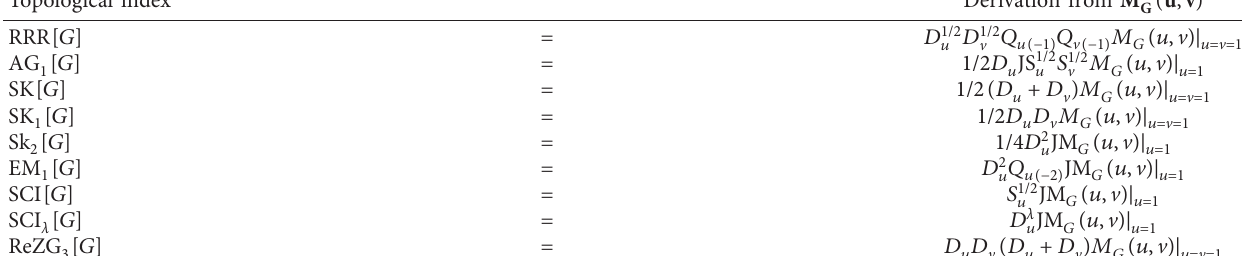
Table 1: Topological indices derived from M